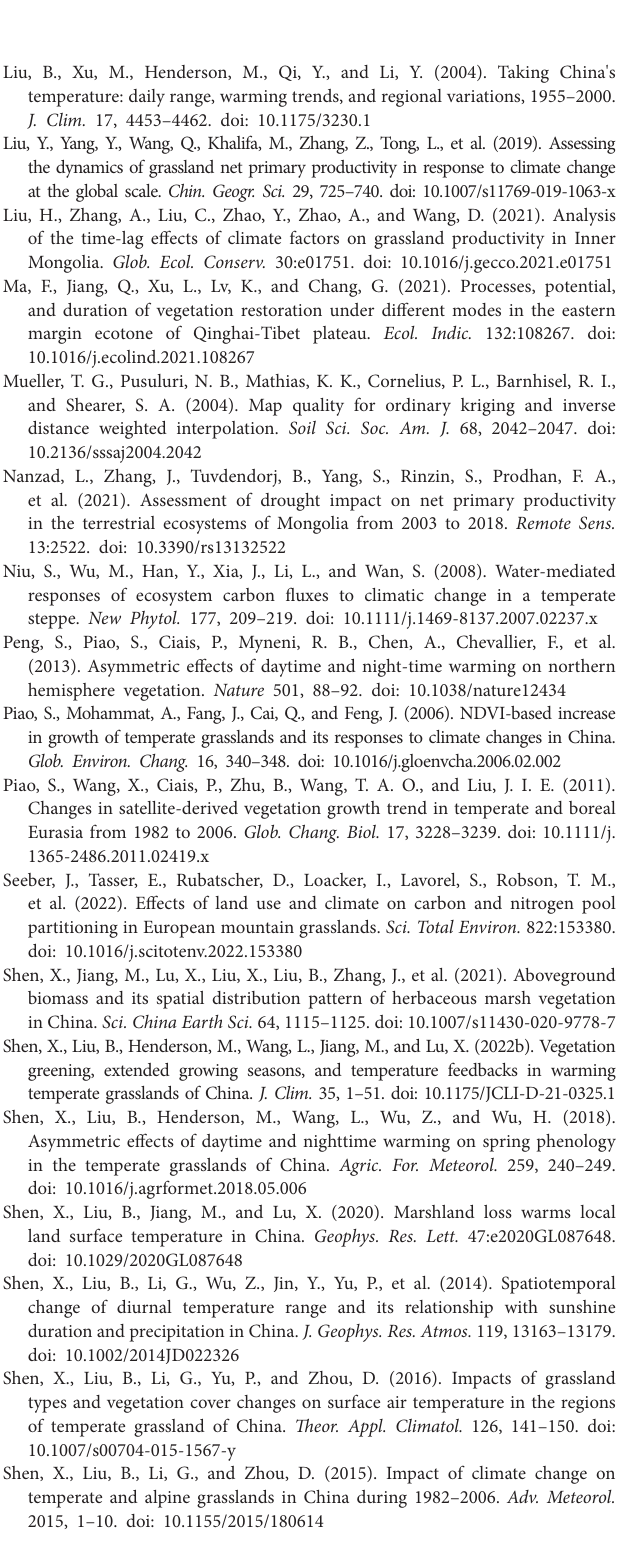
Supplementary Figure 1 | Correlations between annual net primary productivity (NPP) and autumn precipitation (A) , autumn mean temperature (B) , autumn maximum temperature (C) , and autumn minimum temperature (D) of temperate grasslands in China during 2000–2020.